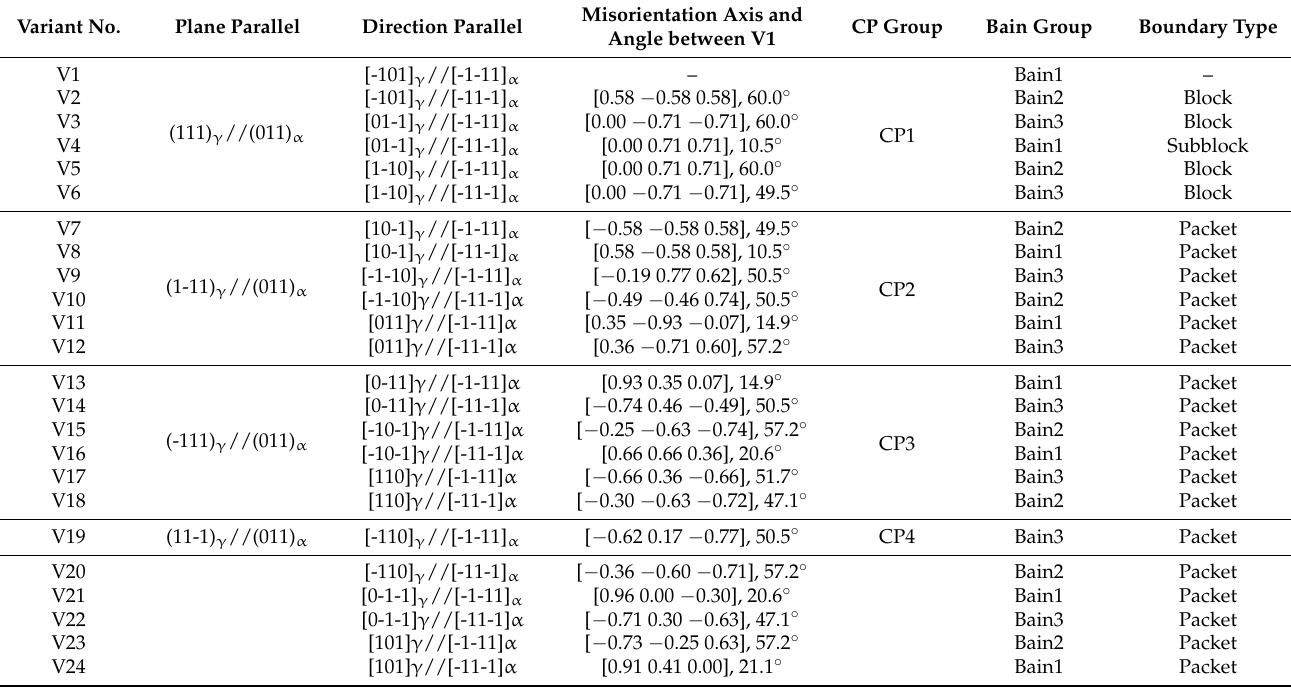
Table 1. The 24 crystallographic variants in K–S OR